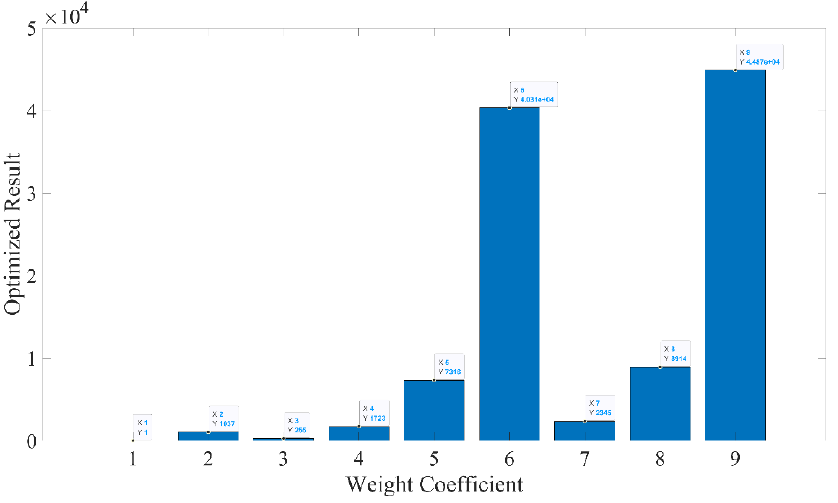
Figure 4. Optimization results of genetic algorithm.